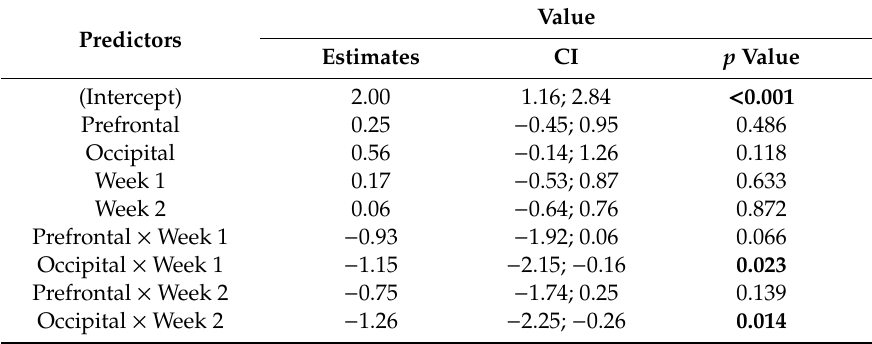
Table 5. Mixed-e ff ect model for the number of consumed tablets per days with the ‘patient ID’ being considered as random e ff ect and the interaction between the brain stimulation condition and time as fixed e ff ect.